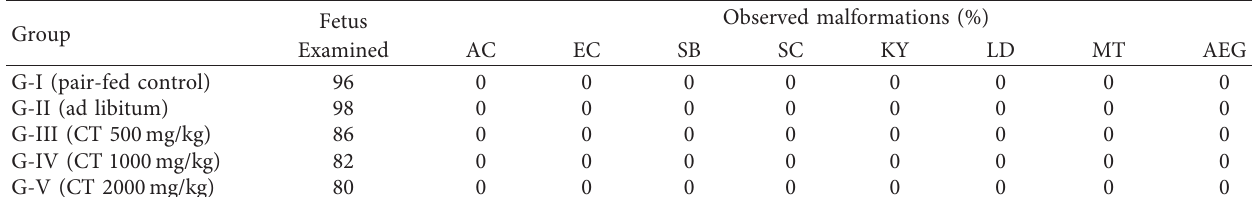
Table 7: External malformations of rat fetuses after administration of the essential oil of Thymus schimperi . Group